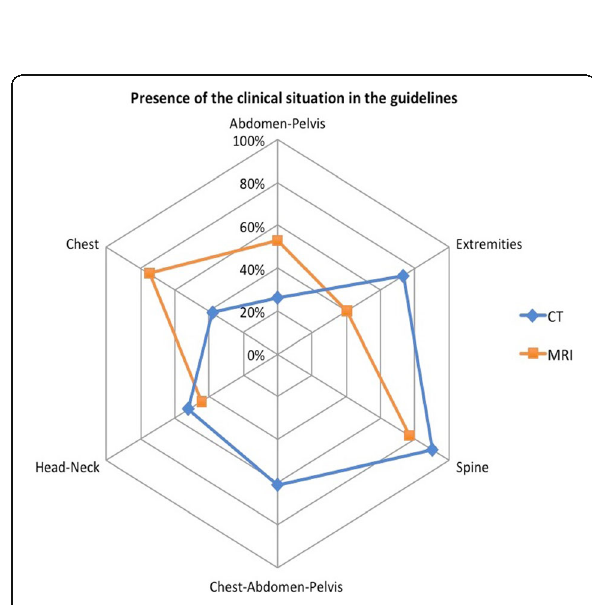
Fig. 6 Radar chart showing for each anatomical area the proportion of inappropriate CT and MRI requests for which the described clinical situation was found in the referral